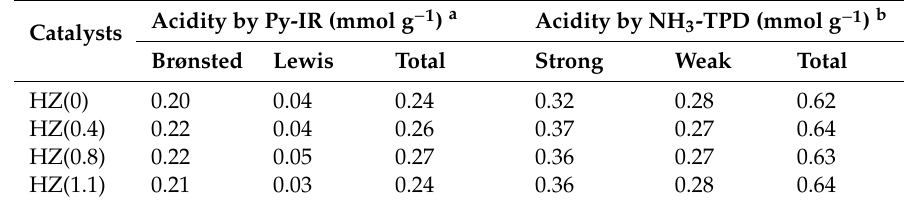
Table 3. Acidic properties of the catalysts based on pyridine adsorption IR and NH 3 -TPD analysis.